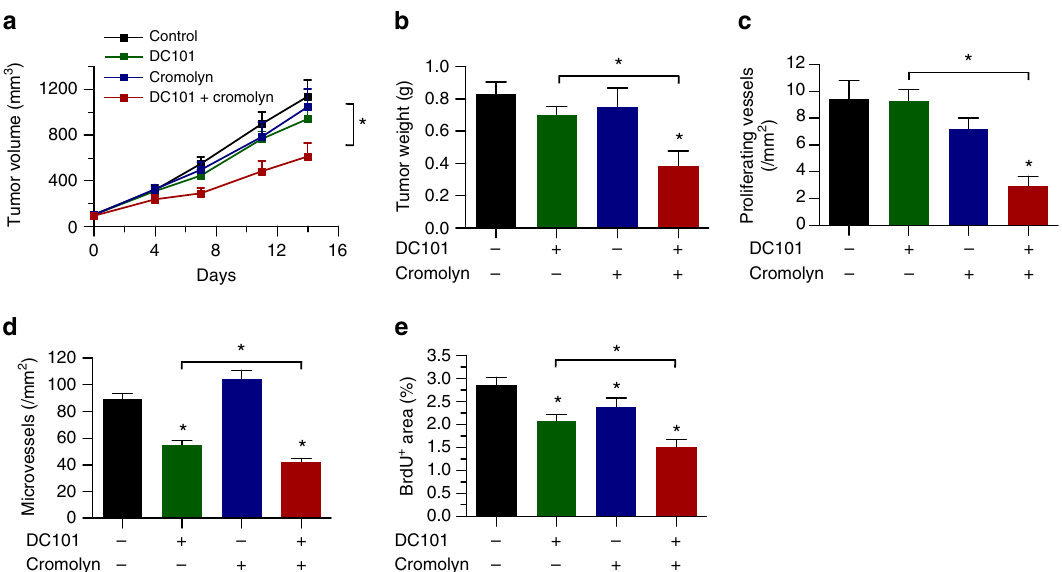
Fig. 6 Pharmacological inhibition of mast cell degranulation increases ef fi cacy of AAT. a Kinetic of subcutaneously growing Panc02 tumors expressed as tumor volume. Panc02 tumor cells were transplanted into the fl anks of C57Bl/6J mice. After randomization, animals were treated with 20 mg/kg DC101 or 25 mg/kg cromolyn in single and combinatorial therapy ( n = 7/8/7/8; * p < 0.05; two-way ANOVA). b Weight of end-stage Panc02 tumors at day of euthanasia ( n = 8/7/8/7; * p < 0.05; one-way ANOVA). c – e Histomorphometric quanti fi cation of BrdU + CD105 + proliferating ( c ) and CD31 + total ( d ) tumor microvessels and of BrdU + tumor area ( e ) ( n = 8/7/8/7; * p < 0.05; one-way ANOVA). Results are shown as representative means ±